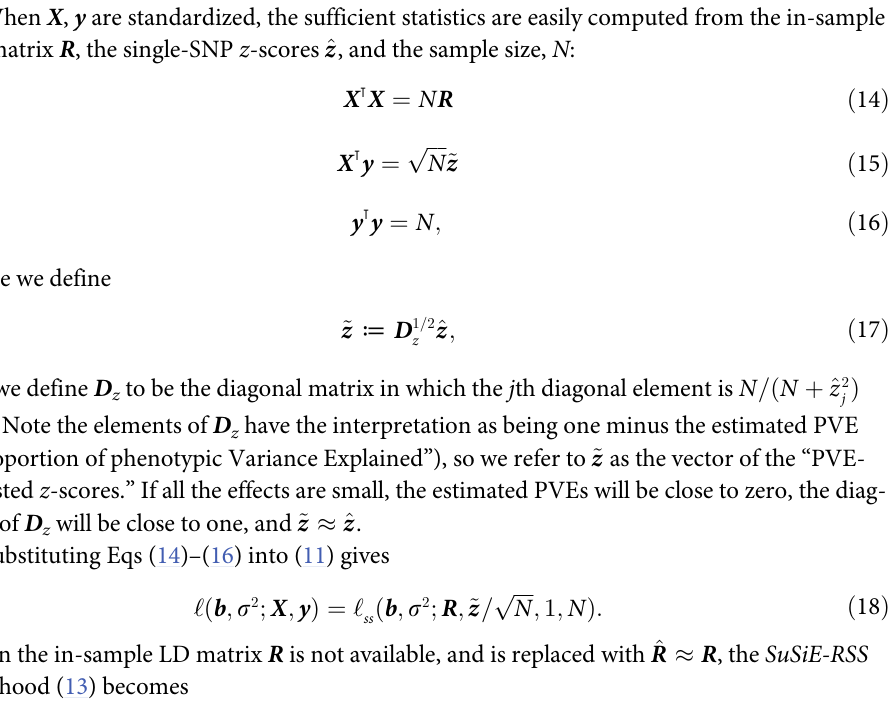
^ z is the vector of z